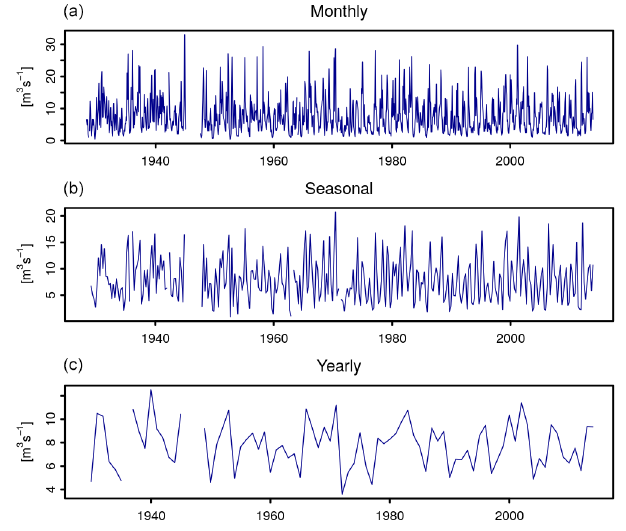
Figure 3. Monthly, seasonal, and yearly MEAN for the River Wiese at Zell, south-western Germany. Index values are only displayed if they fulfil the ECA&D13 data availability criteria. See the text for